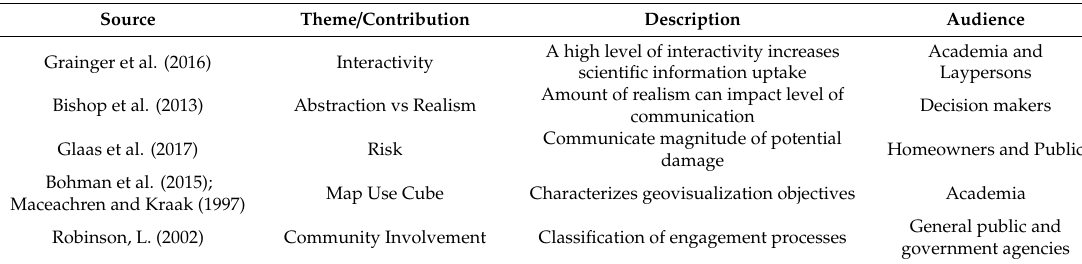
Table 1. Summary of research used in formation of the CVAP